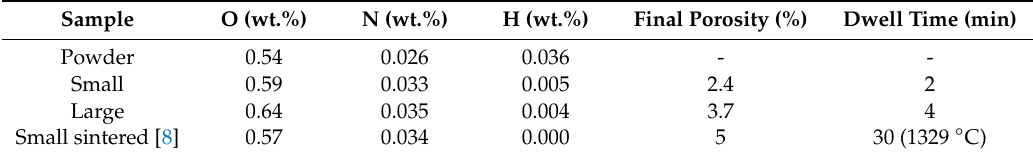
Table 2. ONH chemical analysis results for melted titanium samples in solar